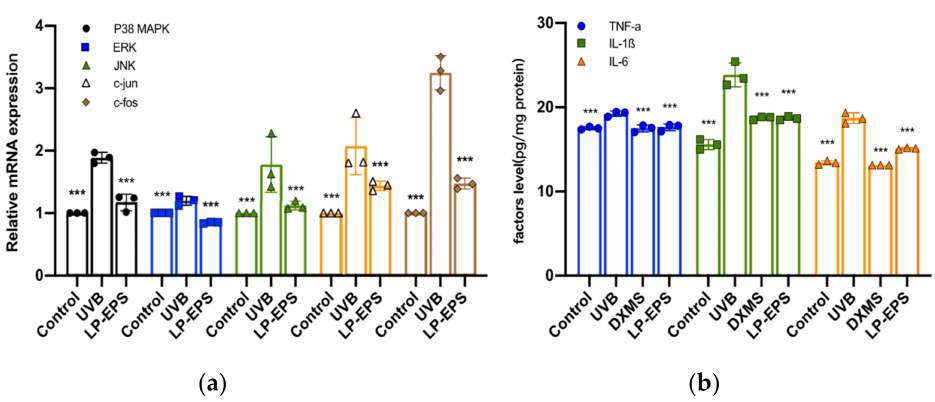
Figure 5. Molecular biology level experiments: ( a ) mRNA expression levels of key factors in MAPK signaling pathway; ( b ) levels of key cellular inflammatory factors secreted by HaCaT. ***: p <